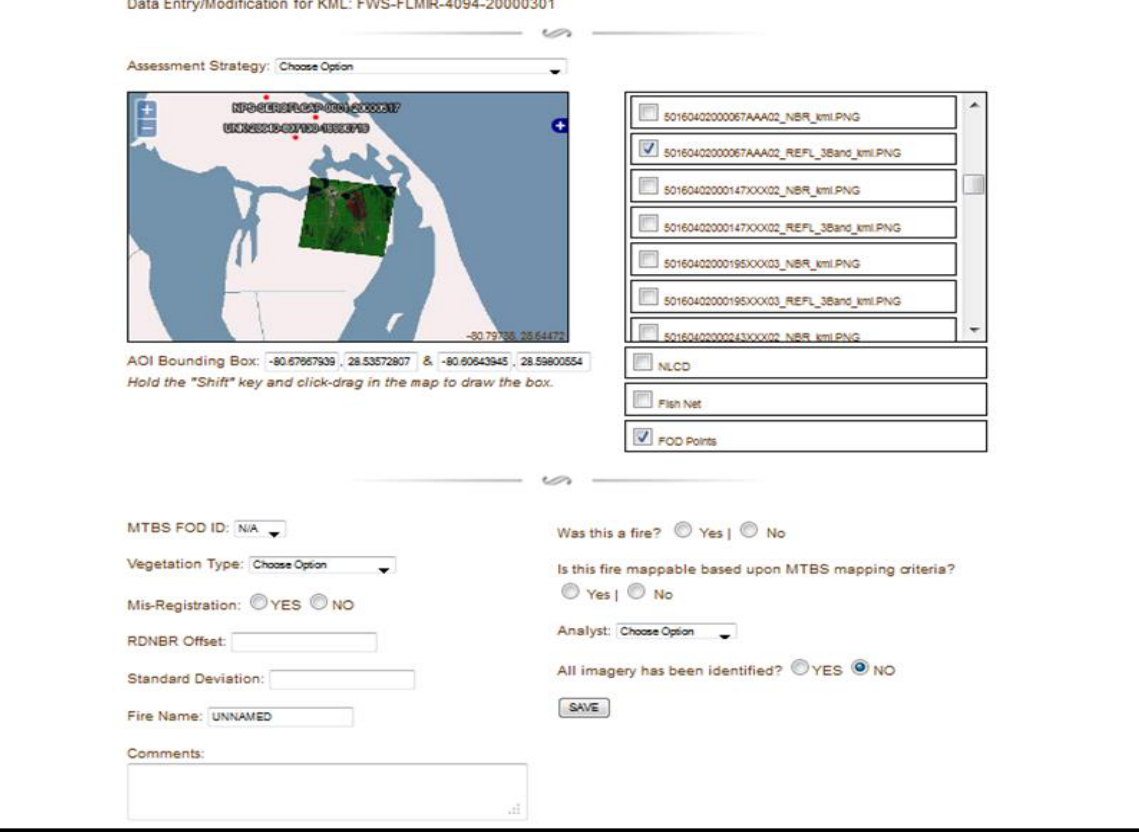
Figure 4. MTBS QuickLook viewer tool. The interface displays full resolution Landsat subsets, yearly NDVI curves, and provides a pick-list to record analysts’ scene selections and processing